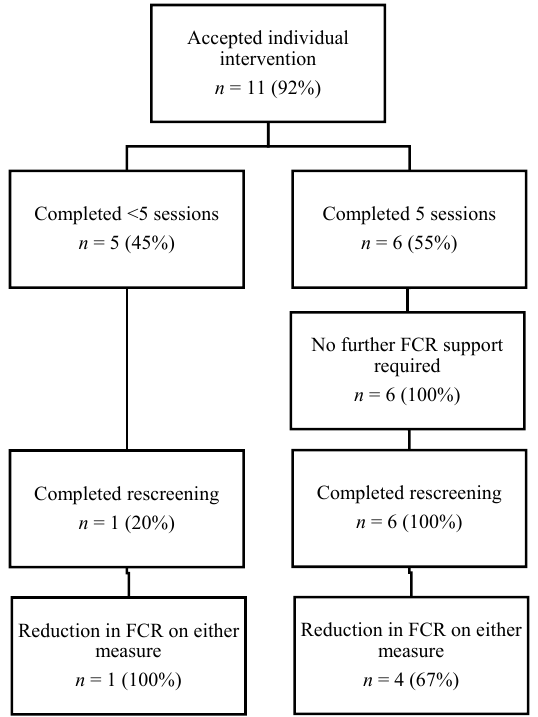
Figure 4. Individual therapy flow of participants.